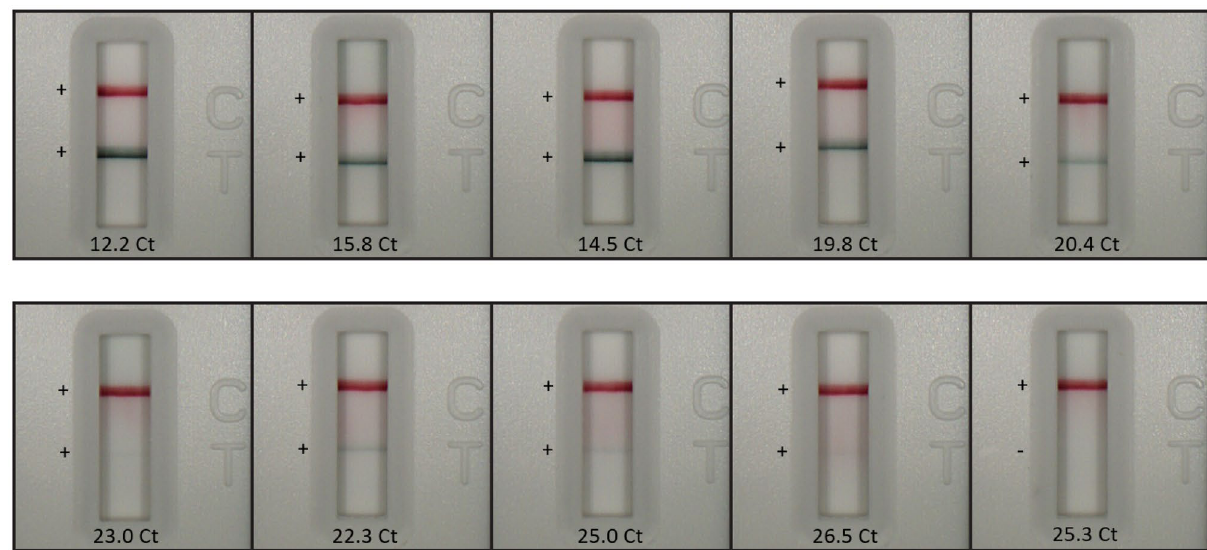
Figure 8. Representative test images of test kit-based study. Visual inspection of SARS-CoV-2 RDT cassettes with different viral load shows diminishing test line signal with decreasing amount of applied virus. Images of RT-qPCR known positive SARS-CoV-2 saline swab samples were collected 15 min from sample application; 400 µL of saline swab sample was added to sample extraction buffer tube and evaluated on SARS-CoV-2 antigen RDT. N1 Ct value for each sample is depicted on its corresponding